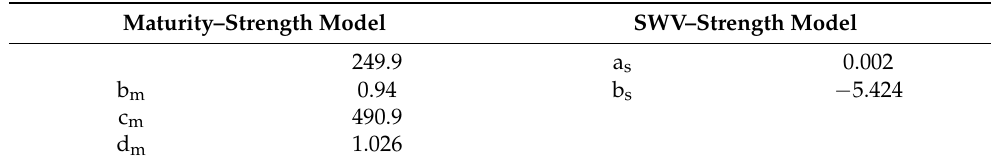
Table 2. Strength model